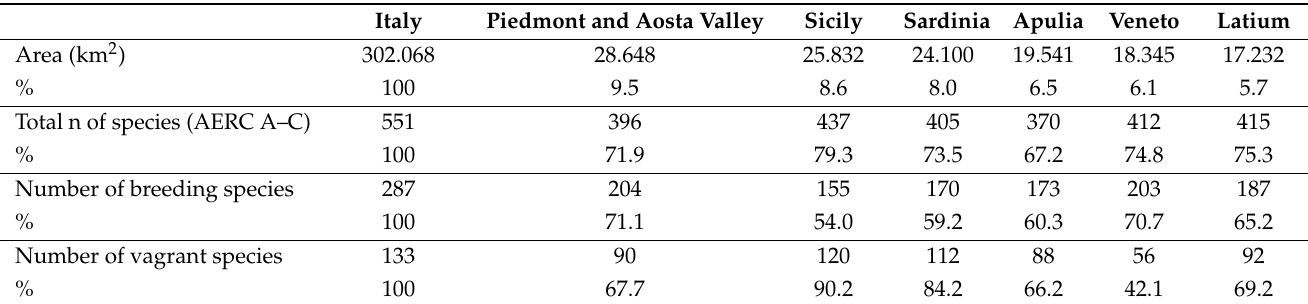
Table 6. Total number of recorded species (AERC A–C categories), breeding species, and vagrant species on the national checklist and some regional checklists. The regions are ordered by surface area. Data source: Italy [17]; Piedmont and Aosta Valley, this work; Sicily [158]; Sardinia [159]; Apulia [160]; Veneto [161]; Latium [162]. See text for